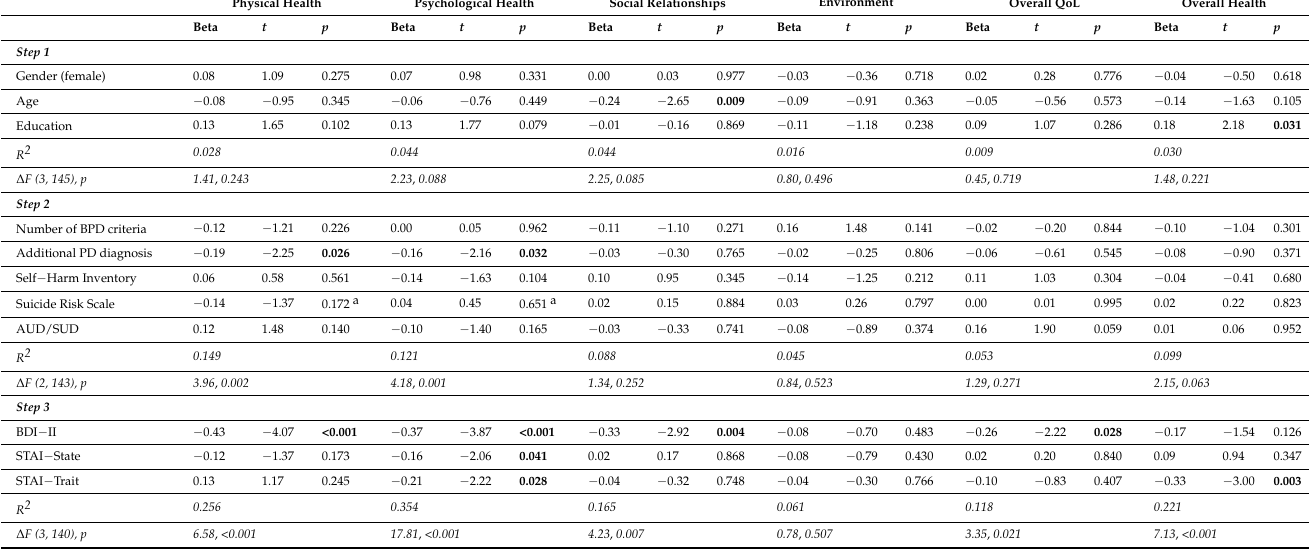
Table 2. The effect of demographic and clinical factors on WHOQOL-BREF domains in patients with BPD ( n = 150). Hierarchical linear